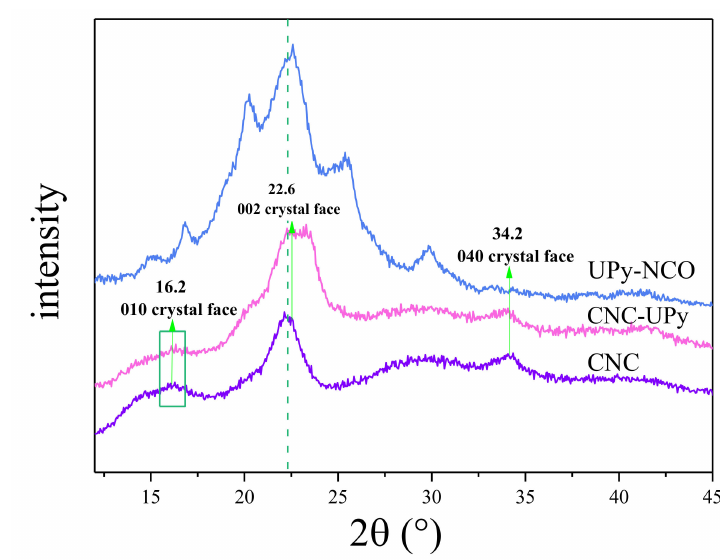
Figure 2. XRD curves of CNC, UPy-NCO and CNC-UPy.